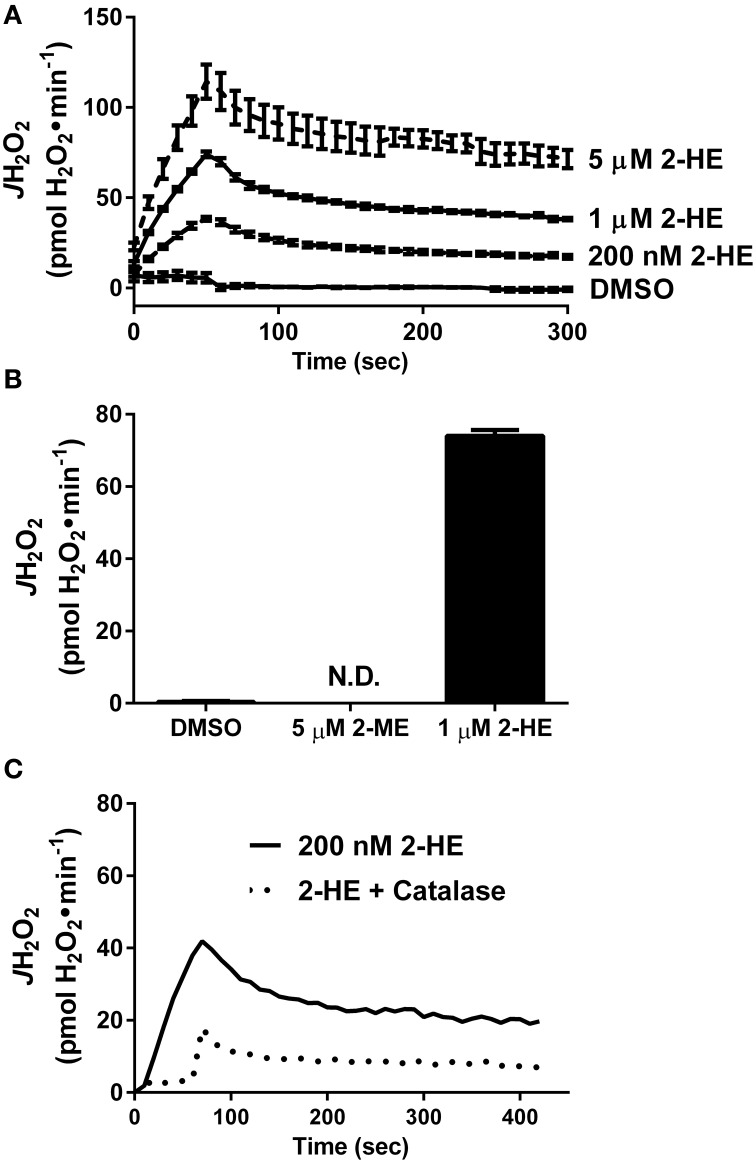
The soluble adenylyl cyclase inhibitor 2-hydroxyestradiol (2-HE) produces H2O2 in a cell-free system. (A) Comparison of H2O2 production from 2-methoxyestradiol (2-ME) and 2-hydroxyestradiol (2-HE). (B) Dose-dependent rate of H2O2 production of 2-HE over a 5-min span. Results in (A,B) are the product of N=3 separate experiments. (C) H2O2 production by 200 nM 2-HE in the absence (solid line) or presence (dashed line) of 100 U/ml catalase.